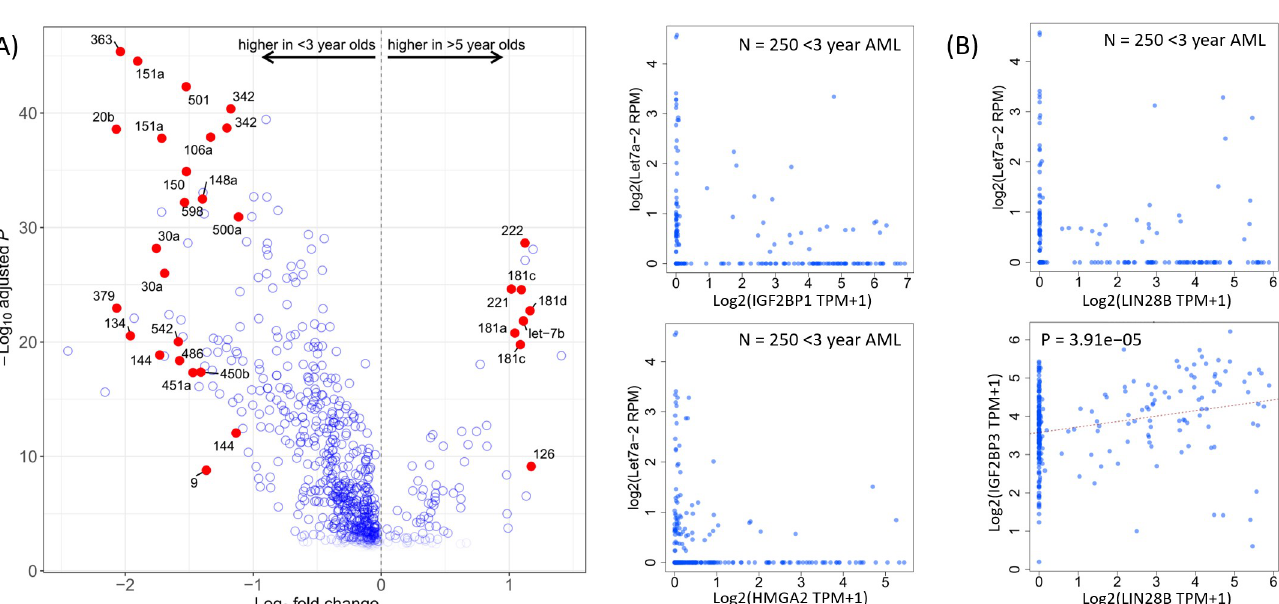
PLOS ONE | https://doi.org/10.1371/journal.pone.0259197 November18,